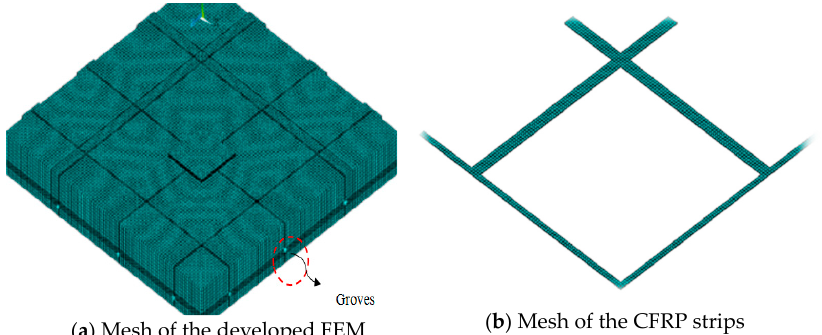
Figure 11. FEM half-scale model meshing.